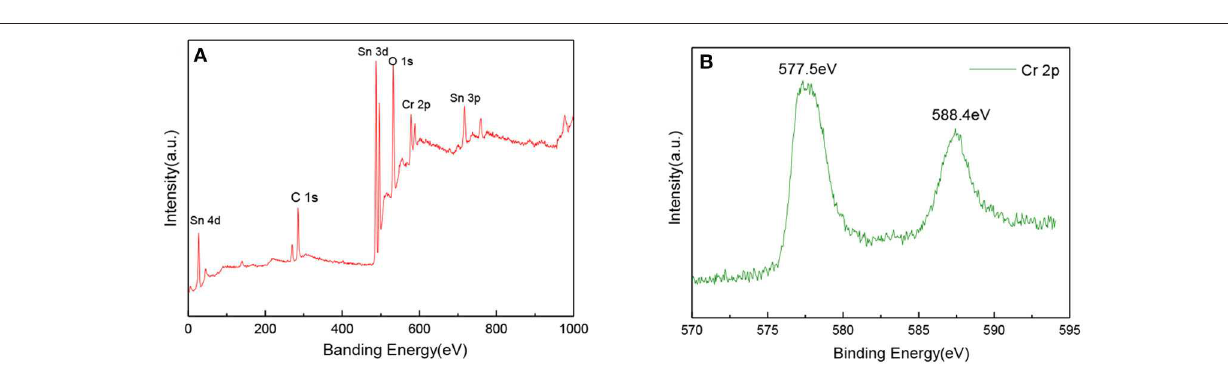
FIGURE 4 | (A) The XPS spectrum of the Cr 2 O 3 NPs. coated SnO 2 NFs. sample, and (B) XPS spectrum of Cr 2p.